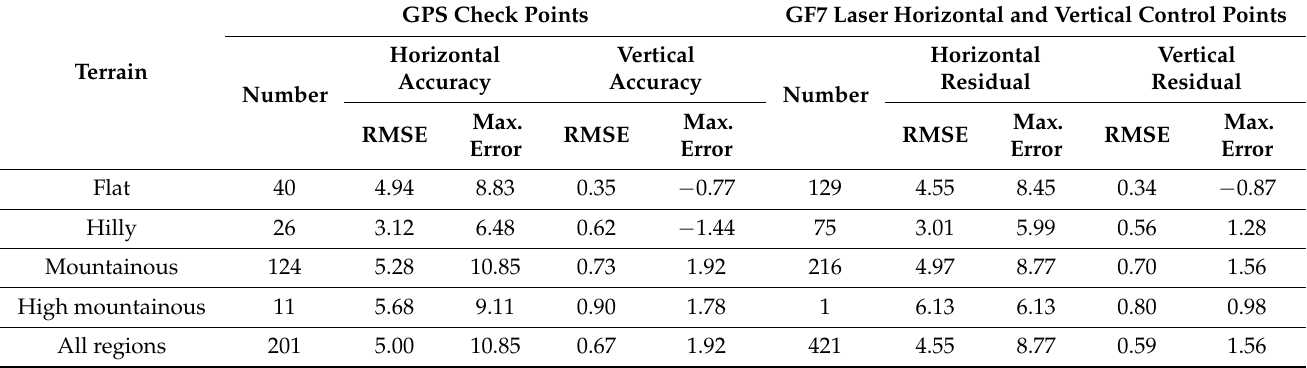
Table 7. Experimental results of integrated processing of GF7 experimental data (second group).